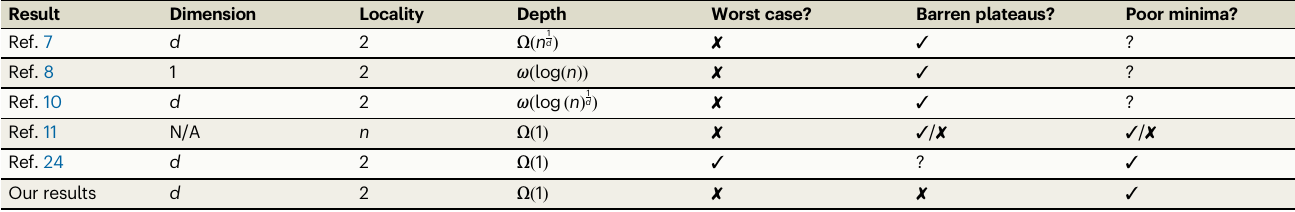
Table 1 | A summary of previous results on the untrainability of variational quantum algorithms Result Dimension